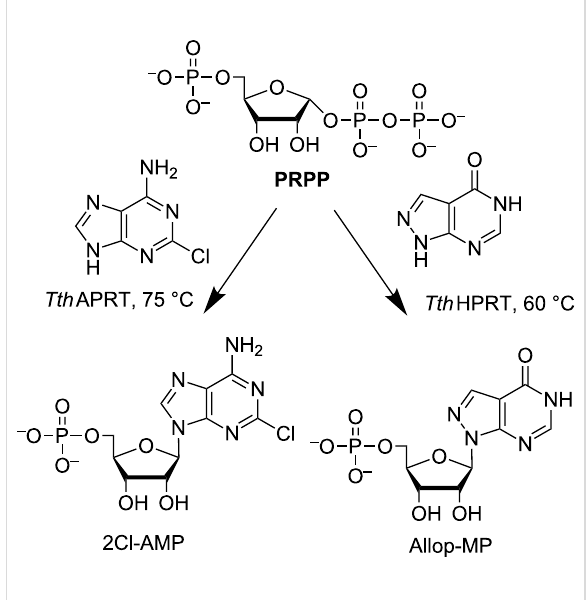
Figure 6: Synthesis of nucleotides 2Cl-AMP and Allop-MP using phos- phoribosyltransferases Tth APRT or Tth HPRT